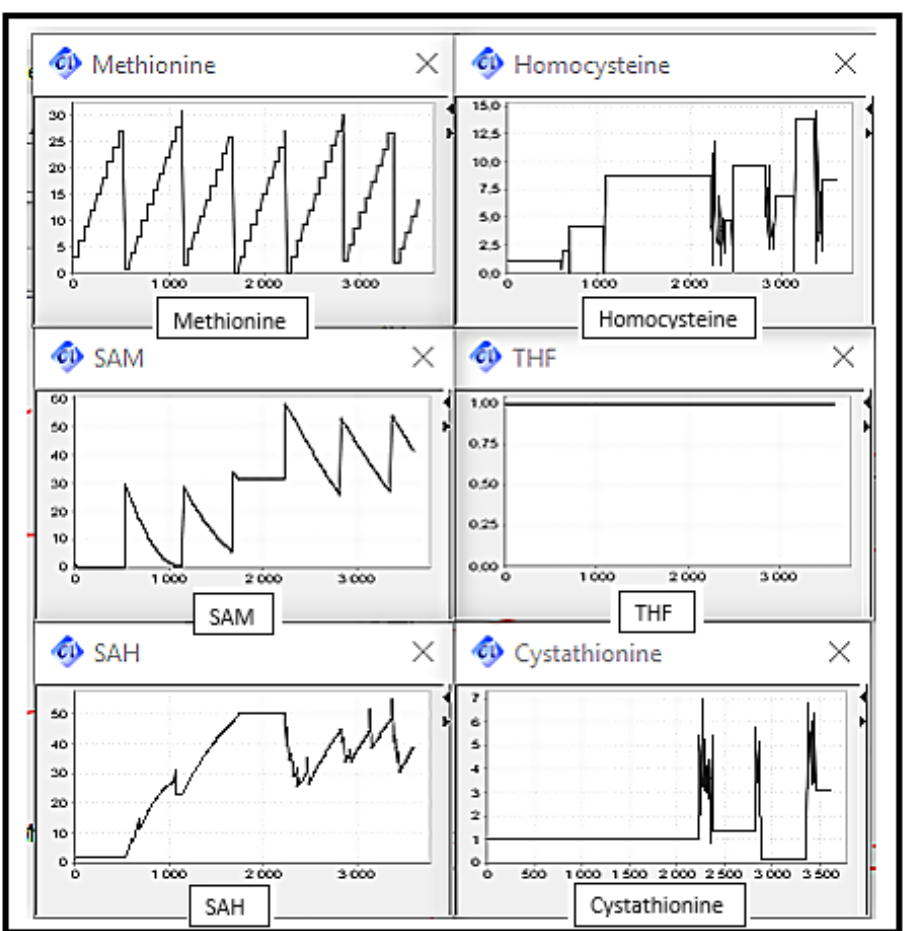
Figure 10. Simulation of the HFPN model representing the studied metabolic pathway in case of MS and BHSM Deficiencies (Scenario